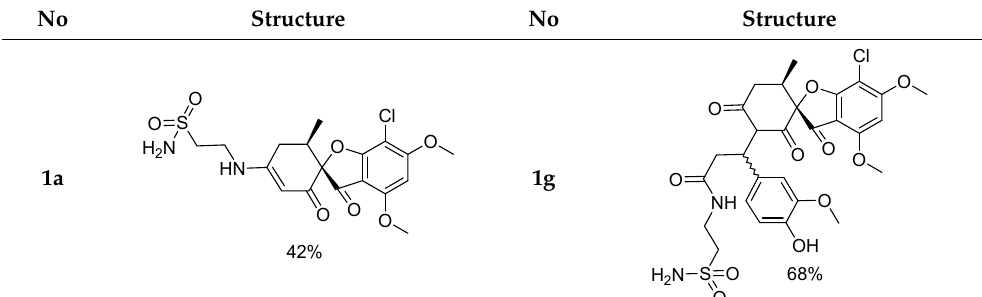
Table 1. Structures of compounds.